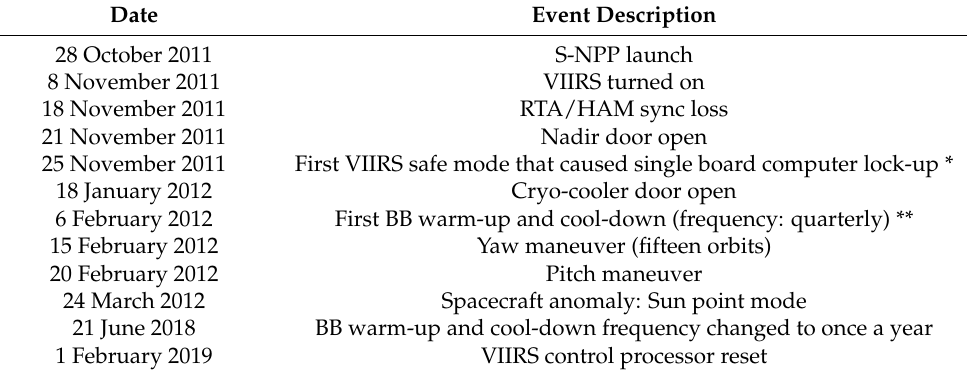
Table 2. Significant events for S-NPP VIIRS on-orbit operation and TEB calibration.